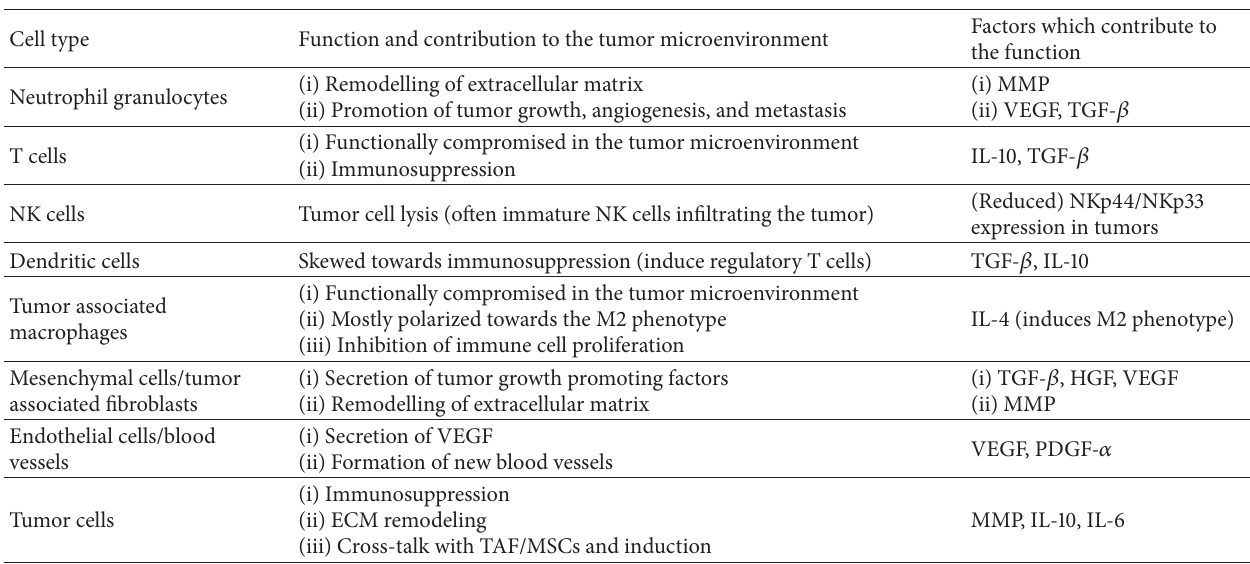
Table 1: Overview on cell types that are present within the tumor microenvironment (based on [7, 59]). Cell